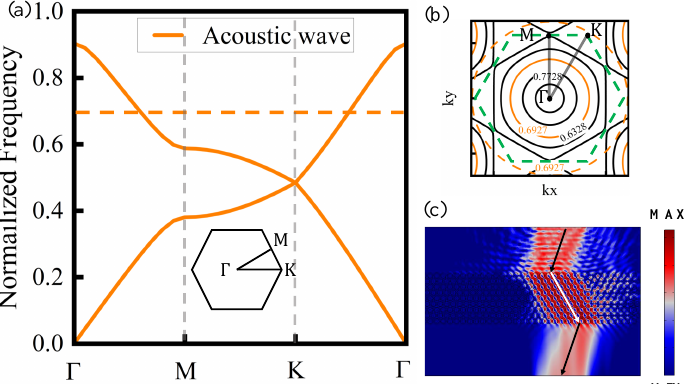
Figure 3. ( a ) Phononic band structure of the PxC, with the orange solid and dashed lines correspond- ing to the normalized frequency of 0.6927(v/a) in PxC and air, respectively. ( b ) EFCs of the second band. The orange contours represent the frequency of 0.6927(v/a). ( c ) Acoustic negative refraction at the frequency of